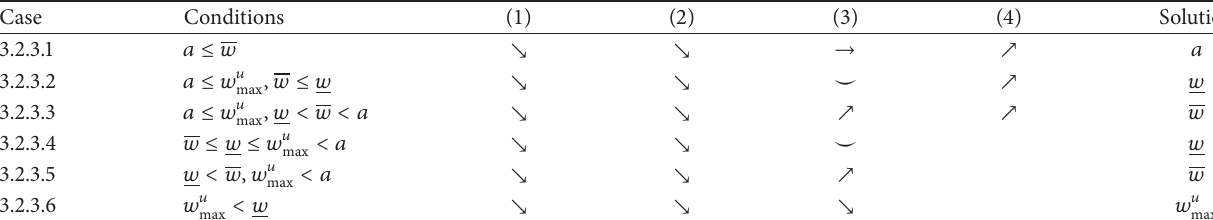
Table 12: Case 3.2.3